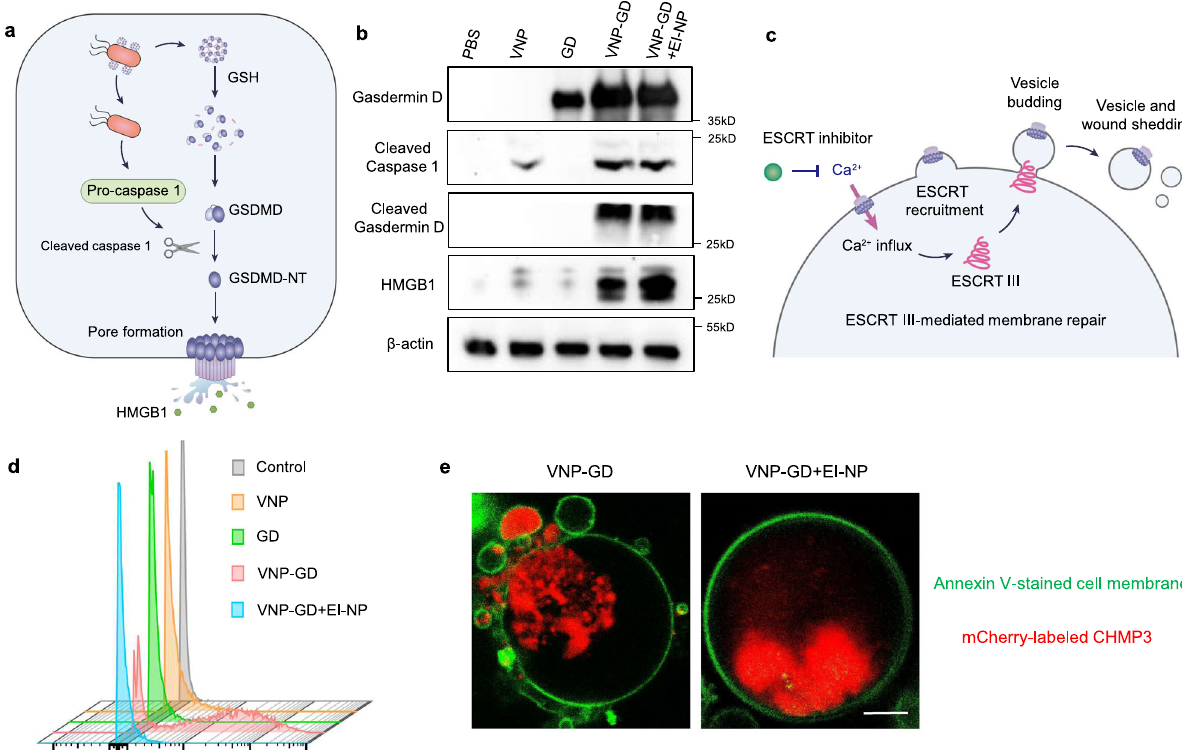
Fig. 3 | Working mechanism of GSDMD-induced pyroptosis and ESCRT III- mediatedcellmembranerepair.a Schematicillustrationofthepyroptosis-related signaling pathway. b Western blot assay of the pyroptosis signaling pathway in 4T1cellsaftertreatmentsofPBS,VNP,GD(GSDMDproteincage),VNP-GD(GSDMD protein cage-conjugated VNP), and VNP-GD+EI-NP (GSDMD protein cage- conjugated VNP+EI-NP). The experiments were repeated three times indepen- dently. c Schematic illustration of the calcium in fl ux induced ESCRT III-mediated membrane repairduring cancercellpyroptosis. d Flow cytometryassayof the Ca